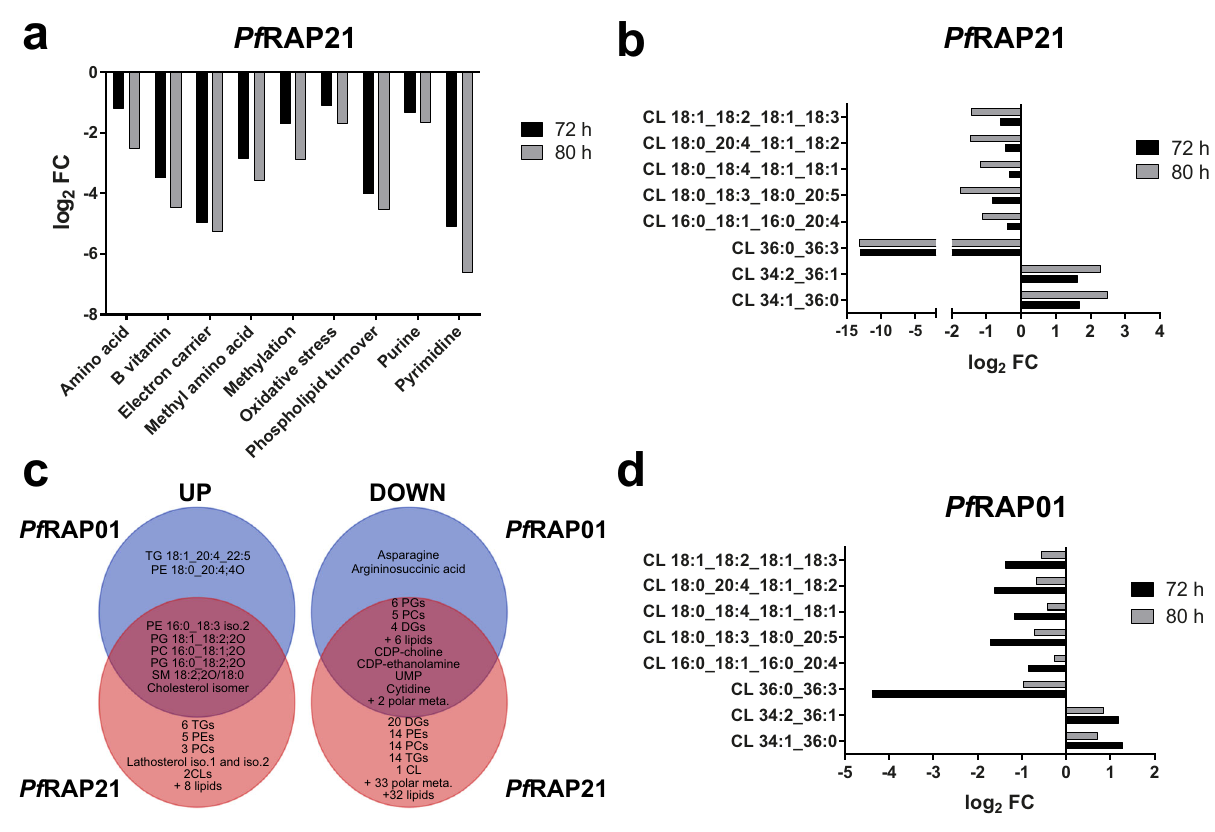
Fig. 5 Metabolomics analyses of Pf RAP01 and Pf RAP21 knockdowns. a Average relative log2 FC ( − aTc/ + aTc) of the polar metabolites grouped in their respective pathways from Pf RAP21 samples at 72 and 80 h. b Relative log2 FC ( − aTc/ + aTc) of cardiolipins (CL) detected in lipidomics analysis of Pf RAP21 lines. c Distribution of metabolites signi fi cantly affected in Pf RAP01 and Pf RAP21 lines. The total number of metabolites in each subgroup is indicated in red. d Relative log2 FC ( − aTc/ + aTc) of cardiolipins (CL) detected in lipidomics analysis of Pf RAP01